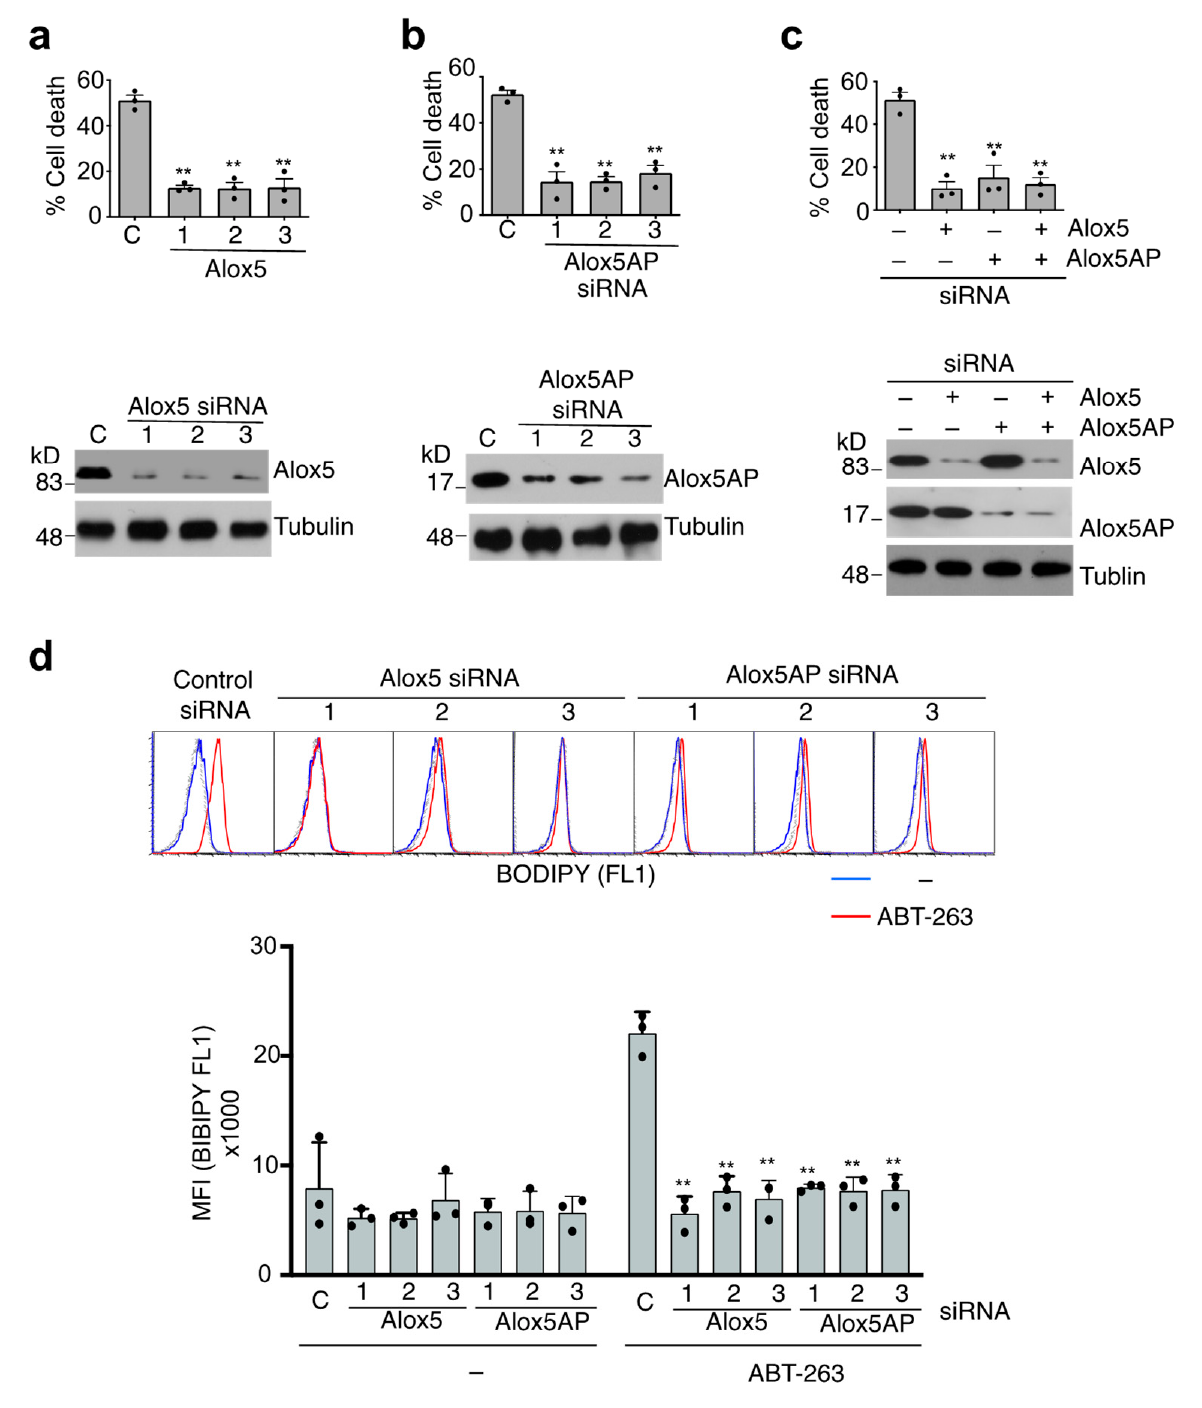
Figure 5. Alox5 and Alox5P in mediating caspase-9-independent cell death. ( a – c ) JMR cells trans- fected with non-targeting control siRNA (C) or individual siRNA targeting ( a ) Alox5 or ( b ) Alox5AP or ( c ) siRNA #1 targeting Alox5 and siRNA #1 targeting Alox5AP. The cells were treated with ABT- 263, followed by quantitation of cell death. The cells were also used for Western blot analyses. ( d ) JMR cells transfected with siRNA targeting Alox5 or Alox5AP as in ( c ) were cultured with or with- out ABT-263, followed by staining with BODIPY 581/591 C11 and analyses by flow cytometry. Dashed line: unstained control. Data are presented as mean ± SD. Comparison with control siRNA group: ** p < 0.01.